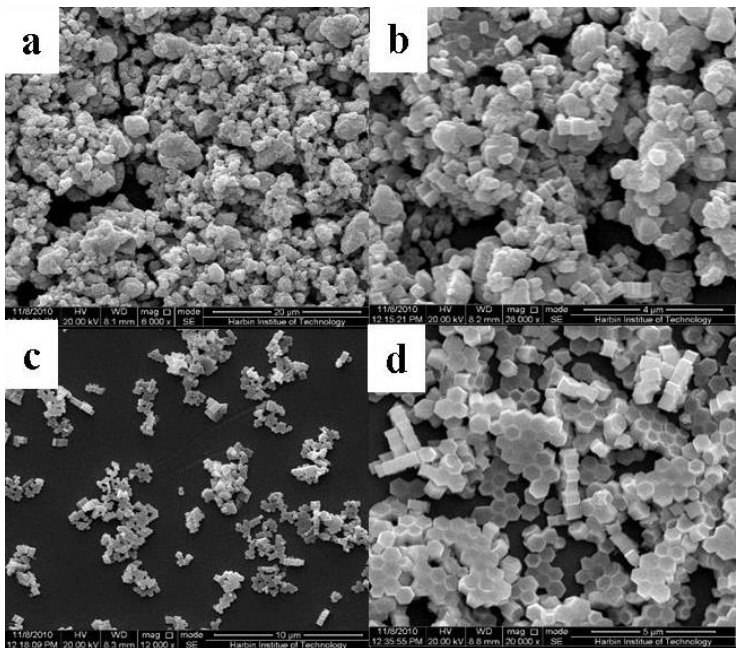
Figure 2. Typical field emission scanning electron microscopy (FESEM) images for the resulting NaYF :10% Nd 3+ , 10% Yb 3+ , 2% Er 3+ microcrystals prepared with different 4 hydrothermal times: ( a ) 3 h; ( b ) 6 h; ( c ) 12 h; and ( d ) 24 h (Other synthetic parameters were kept identical, 180 °C, F − /Ln 3+ = 5:1, OA/Ln 3+ =